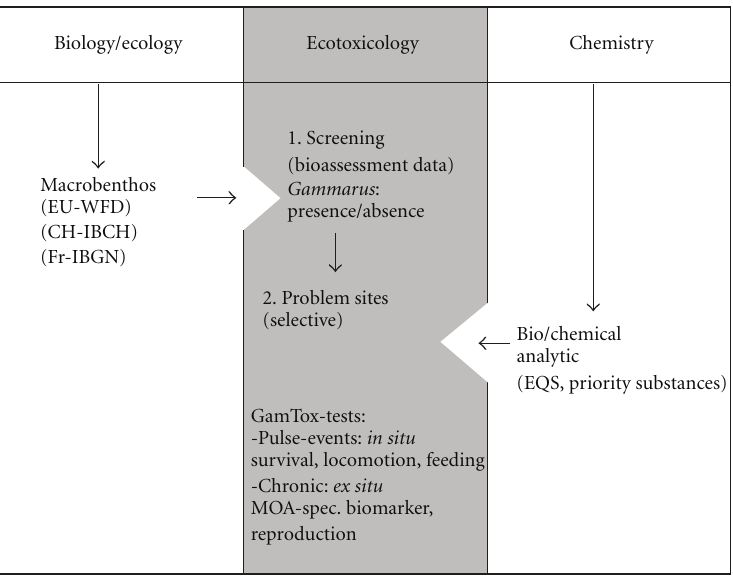
Figure 3: Integrated concept for water quality assessment with a new ecotoxicological